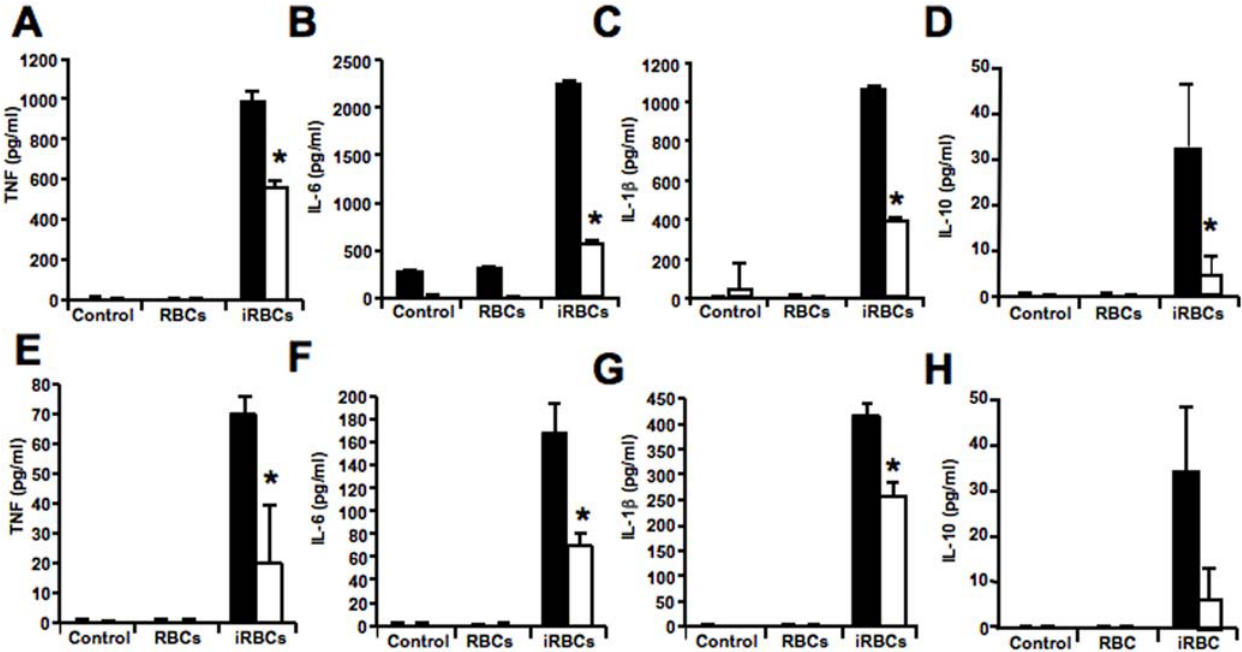
Figure 3. P.falciparum -derived uric acid induces TNF, IL-6 and IL-1 b release from PBMCs. PBMCs were incubated with media alone (control), uninfected erythrocytes (RBCs) or P. falciparum -infected erythrocytes (iRBCs) at a ratio of (5:1; erythrocyte:PBMC) for 6 h (24 h for IL-10) in the absence (black bars) or presence (white bars) of 2 mM allopurinol (A–D) or 0.1 mg/ml uricase (E–H). Incubation media were collected and TNF (A,E), IL-6 (B,F), IL-1 b (C,G) and IL-10 (D,H) concentrations were determined by flow cytometry using cytometric bead array. Data represent the average of triplicated samples with standard deviations. *, indicates significant differences ( p , 0.05) in cytokine release by PBMCs incubated with iRBCs when compared to IRBCs in the presence of allopurinol or